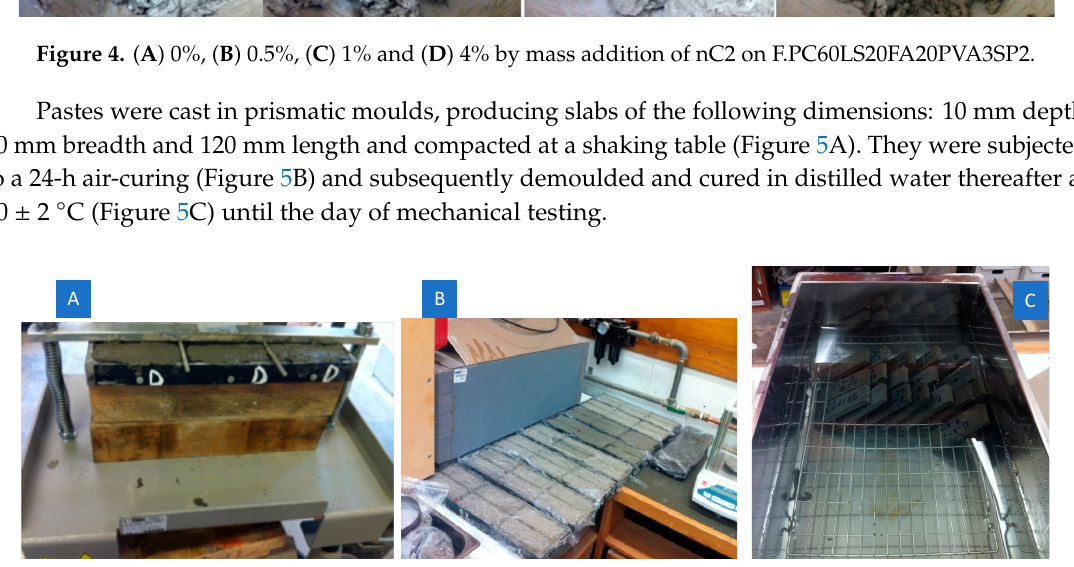
Figure 5. ( A ) Compacting pastes at shaking table, ( B ) initial 24-h air curing and ( C ) water curing